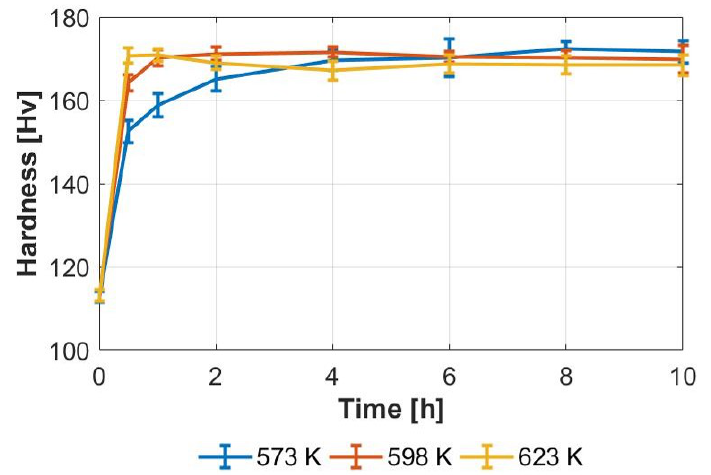
Figure 7. Hardness as a function of ageing time for 3 temperatures: 573 K (blue), 598 K (red) and 623 K (yellow) averaged along XY and XZ directions. Error bars show one unit of standard deviation.